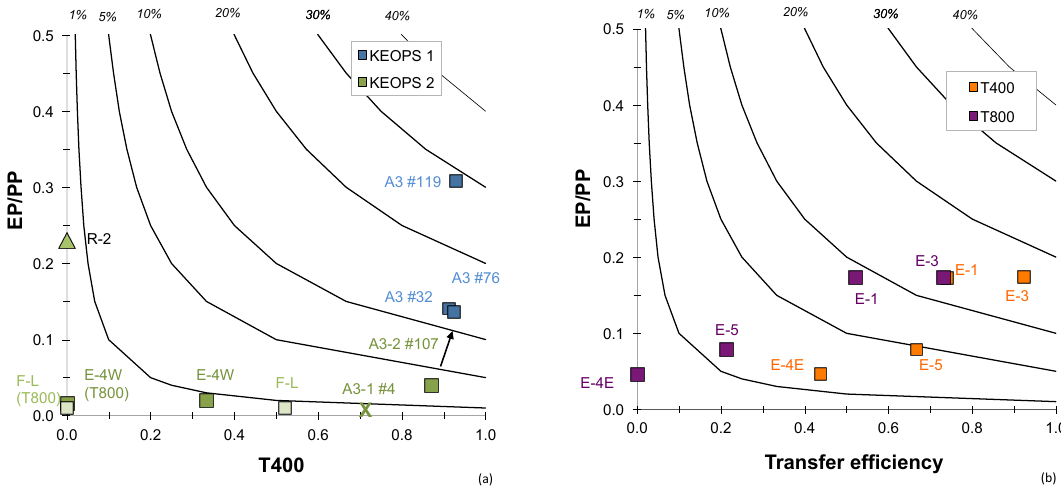
Figure 7. y axis: EP/PP = POC flux at 150m (EP150) as a fraction of primary production (PP); x axis: EPx/EP150 = POC flux at defined depths (EPx; here 400 and 800m) as a fraction of POC flux at 150m (EP150). The green cross (Fig. 5a) is for station A3-1 (KEOPS-2). Since no PP data are available for that station, the EP/PP value has been set to 0. Isolines represent the modelled 1, 5, 10, 20 and 30% of PP export to depths > at 400 or 800m, and represent export